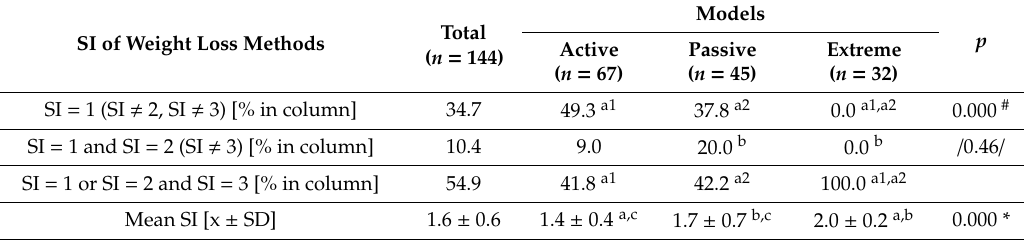
Table 3. Classification of athletes according to the severity index of weight loss methods in weight loss models [%].